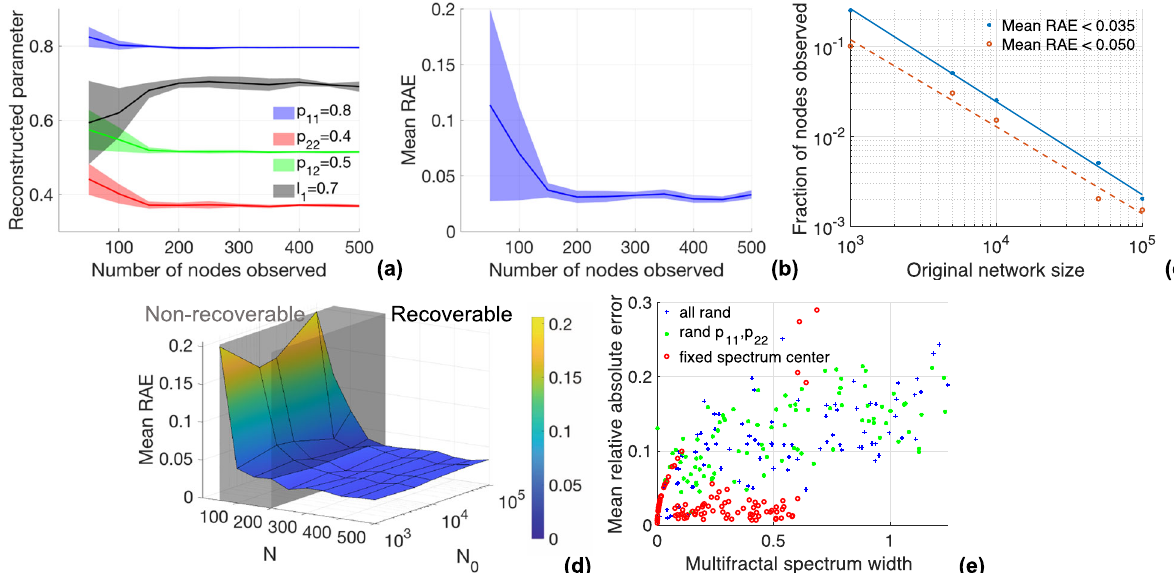
Fig. 4 Model reconstruction from incomplete observations. a Reconstructed parameters of the network generator as a function of the number of nodes observed from the ground-truth network. The simulated graph with N 0 = 100, 000 nodes is generated by parameters shown in the legend. N nodes are randomly chosen and only the links among them are used to reconstruct the weighted multifractal graph model (WMGM). We repeat the experiment 10 times with every N = 50, 100, … , 500. The mean value of each parameter and error is shown in solid lines and shaded area represents the standard deviation. b Mean relative absolute error (RAE) as a function of the number of observed nodes from the entire network. The network generative model can be correctly estimated with low variance when the number of observed nodes exceeds 200. c Fraction of observed nodes needed to achieve a mean RAE less than 0.035 (3.5%) and 0.05 (5%) with the full original network size N 0 = 10 3 , 5 × 10 3 , 10 4 , 5 × 10 4 , 10 5 . Dots and asterisks are the empirical results, and the solid lines are fi tted by power law distributions. The curve is in log-log scale and shows a power law relationship. d 3D plot of the observation size N , the full network size N N , N 0 and the mean error of 10 experiments per ( 0 ). It shows that the hidden generating rule can be recovered (error < 4%) with partial observation of 200 nodes or more, regardless of the original network size. The WMGM is non recoverable when observation size is smaller than 200 nodes (gray area). e The dependency between the mean RAE per parameter and multifractal spectrum width with different properties of the generative model (blue: all parameters are random; green: fi xed linking probability p ð 1 Þ ¼ p ð 1 Þ ¼ 0 : 5 with all other parameters randomly generated; and red: 12 21 fi xed center of multifractal spectrum). In general, introducing randomness can increase the estimation